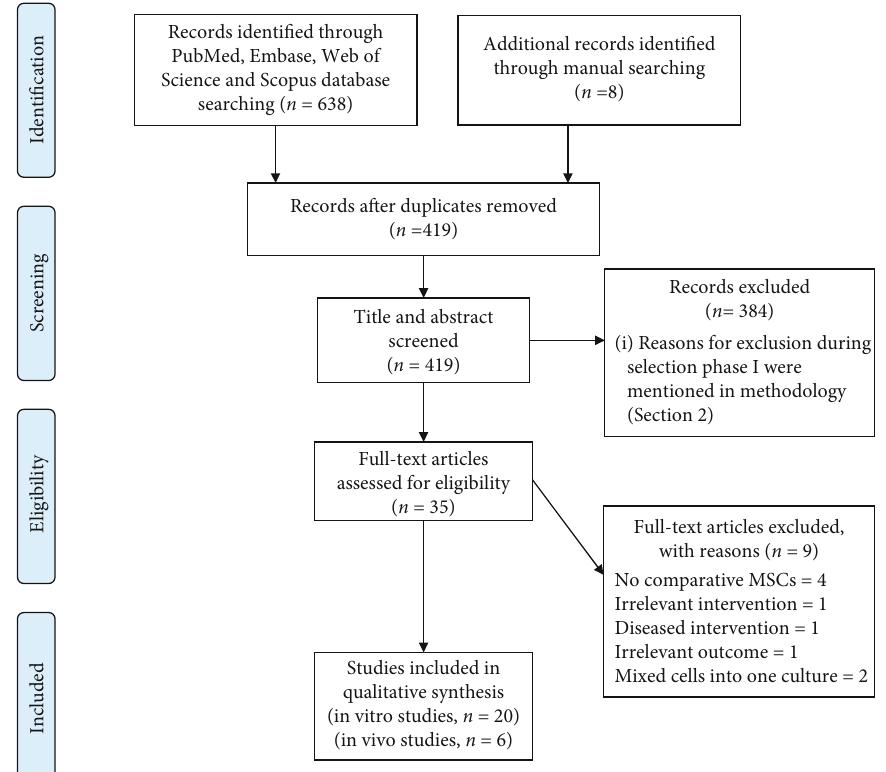
Figure 1: Flow diagram showing the di ff erent phases of literature screening for the systematic review process (editable fi le: PRISMA fl ow diagram, Liberati et al.